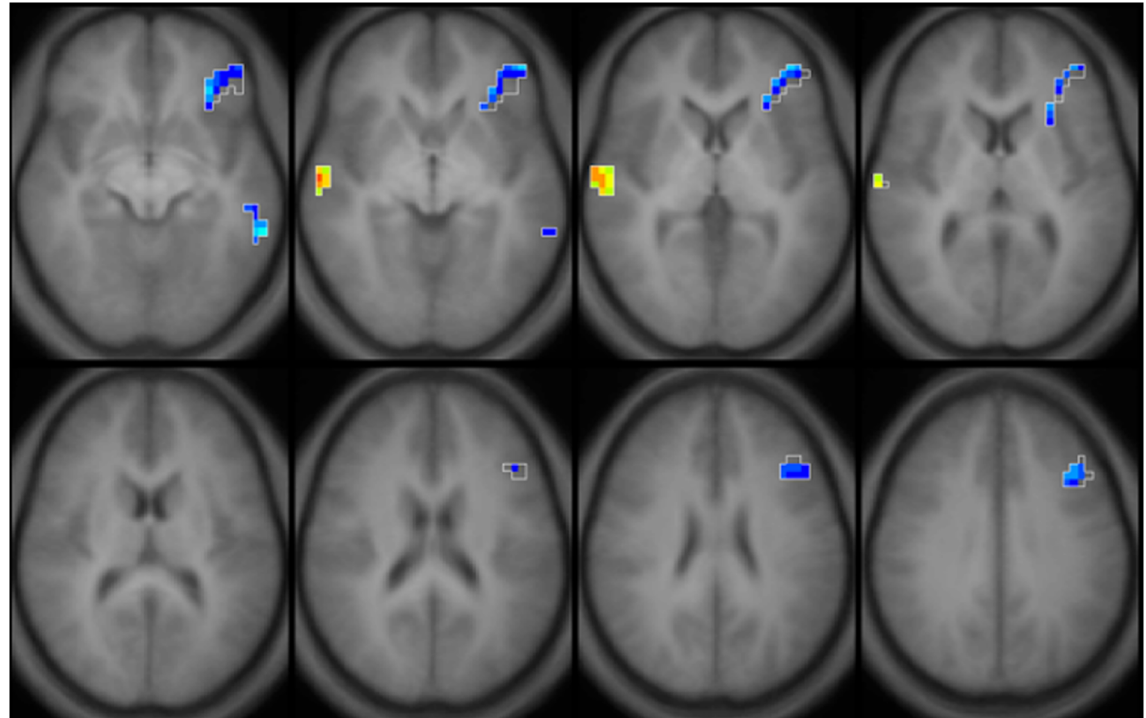
Figure 4. Composite Z-maps showing voxel-wise associations between mean childhood blood lead concentration and fractional anisotropy, mean diffusivity, axial diffusivity and radial diffusivity, respectively, adjusted for significant covariates from left to right for two slice locations, blue at the level of the corona radiata, yellow at the level of the lateral ventricles. The minimum Z statistic was based upon Monte Carlo simulations and corresponds to a two-tailed, corrected voxel-wise p value of <0.05. Blue colors represent inverse associations, yellow-red colors represent direct associations.